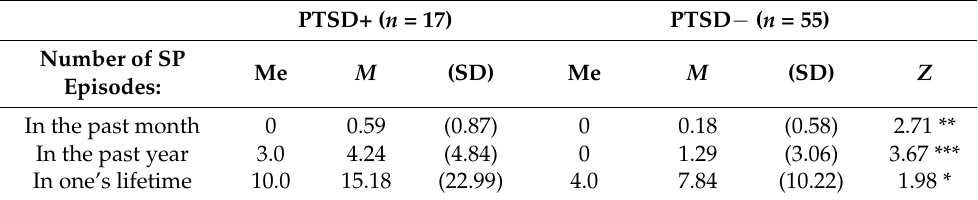
Table 4. Comparison of frequency of SP episodes between firefighters who meet PTSD criteria and those who do not meet PTSD